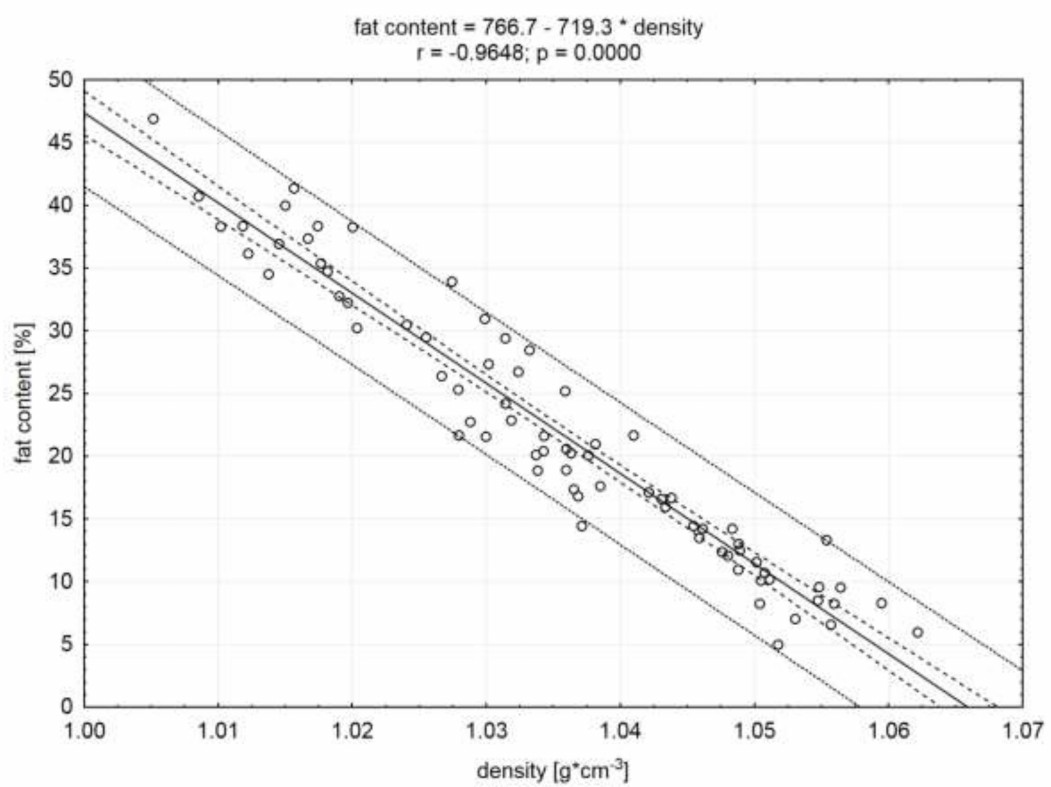
Figure 3. Correlation between fat content and density of the meat. Dotted lines indicate the confidence and prediction curves (for the level of